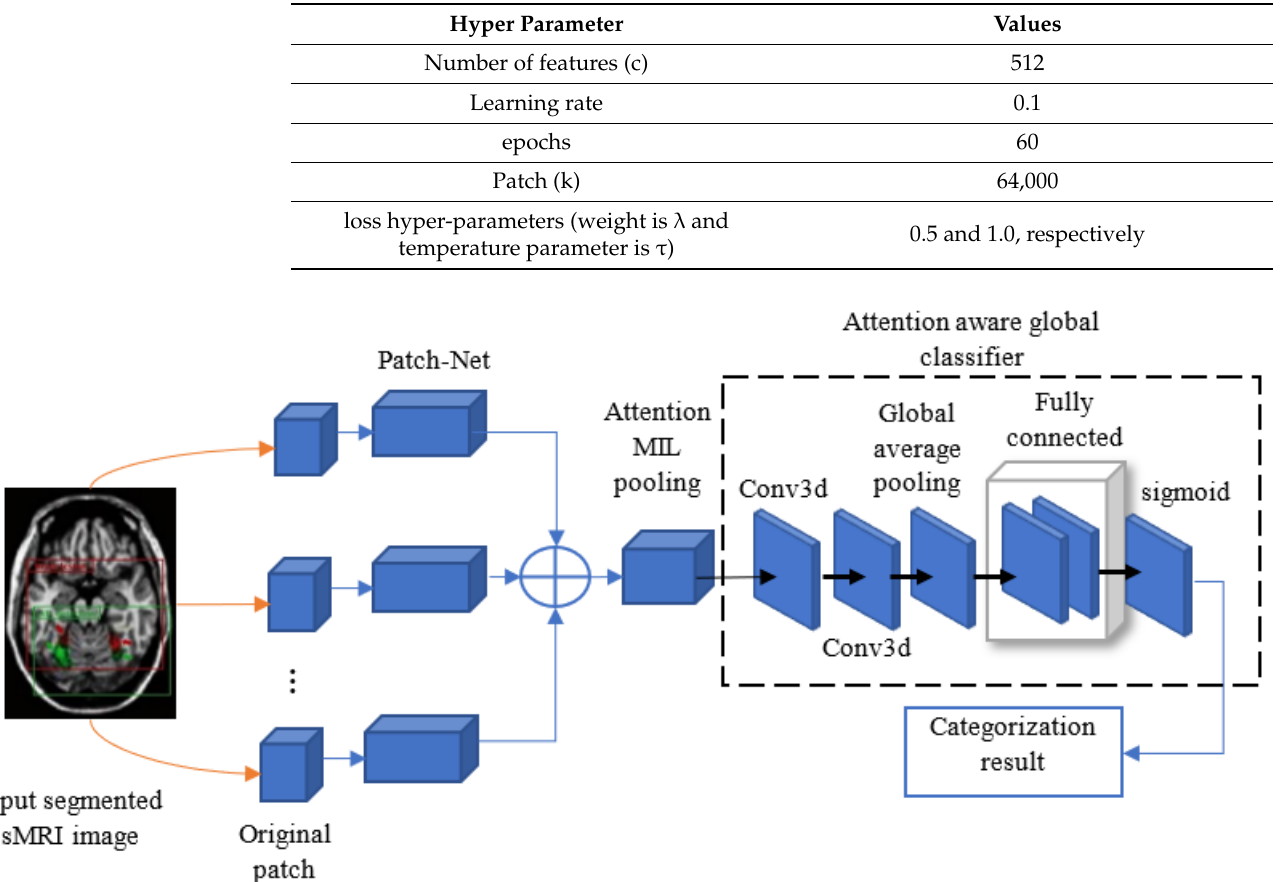
Table 2. Hyper parameter values of DA-MIDL.